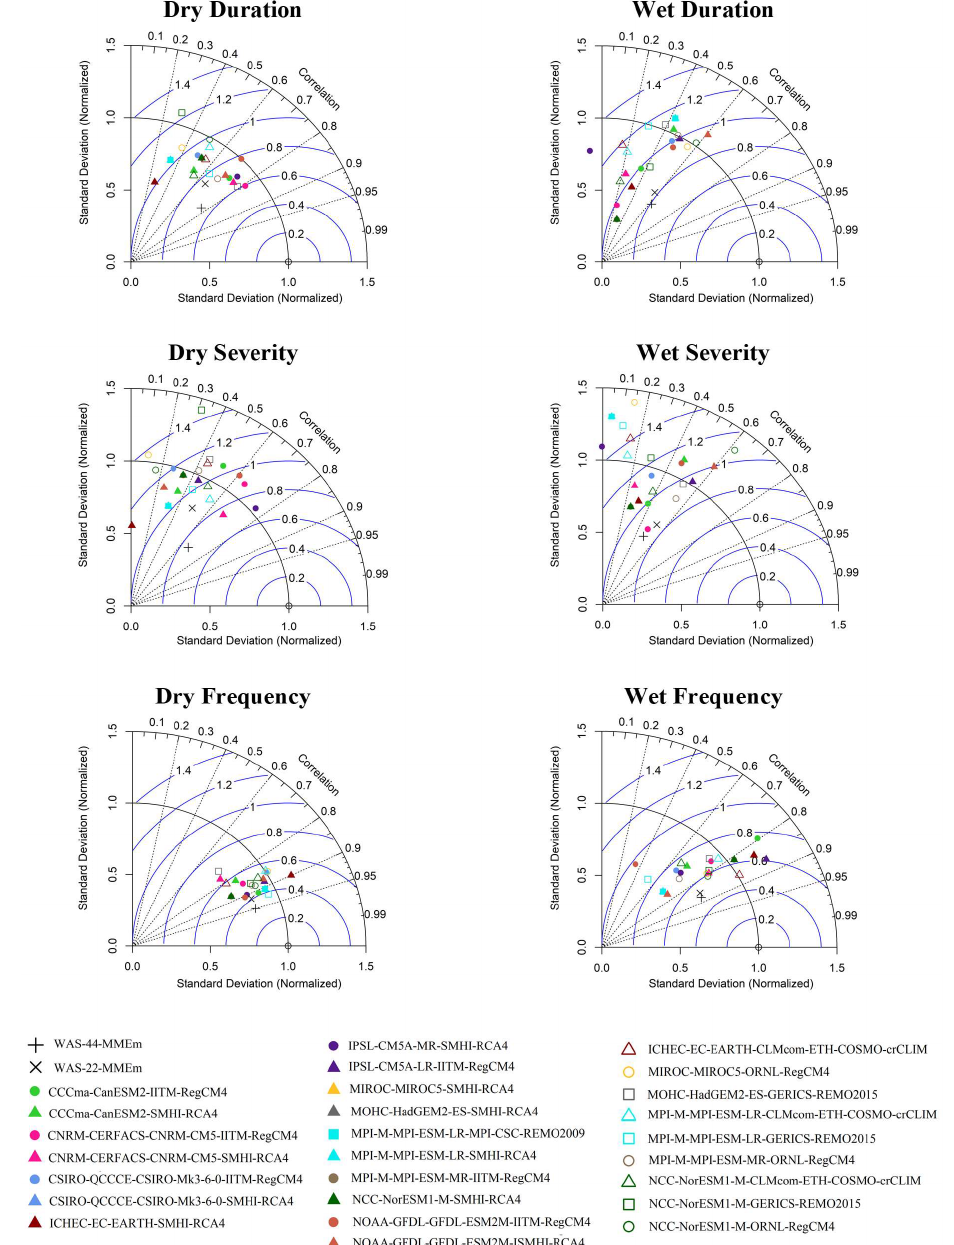
Figure 7. Taylor diagrams showing the performance of individual simulations of CORDEX and CORDEX-CORE experiments bias-corrected using the D-EQM method with respect to the spatial pattern of SPEI indices in the historical period (1986–2005) for the UJB. Filled markers: CORDEX models; non-filled markers: CORDEX-CORE models. Three different markers show the three RCMs in both experiments (i.e., RegCM4, RCA4, and REMO2009 from CORDEX and COSMO, and REMO2015 and RegCM4-7 from CORDEX-CORE); colors show the driving GCMs (same color means same driving GCM); plus marker and cross in black show the multi-model ensemble mean (MMEm) for CORDEX and CORDEX-CORE experiments, respectively. Note: RCA4 driven by CSIRO (filled blue triangle) and ICHEC-EC-EARTH (filled maroon triangle) are grouped together for all SPEI indices. Note: RCA4 driven by MIROC (filled yellow triangle), RCA4 driven by MOHC-HadGEM2 (filled grey triangle), RCA4 driven by MPI (filled cyan triangle), and REMO2009 driven by MPI (filled cyan square) are grouped together for all SPEI indices. Note: RegCM4 driven by MPI (filled brown circle) and RCA4 driven by NCC-NorESM1 (filled dark green triangle) are grouped